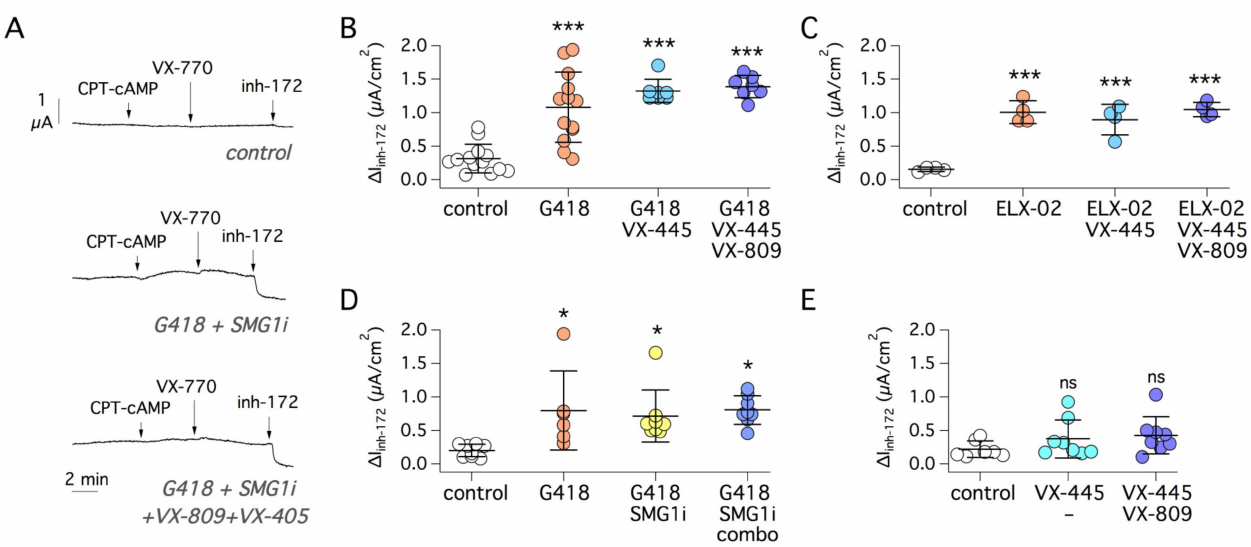
Figure 5. Pharmacological rescue of R1162X-CFTR mutant. ( A ) Representative short-circuit current traces from experiments on 16HBE14o- cells expressing R1162X-CFTR. ( B , C ) Scatter dot plots summarizing the effect of G418 or ELX-02 (both at 0.5 mg/mL) with/without correctors VX-809 (1 µ M) and VX-445 (5 µ M). ***, p < 0.001 vs. control. ( D ) Data obtained with G418, with/without SMG1i (1 µ M), and VX-809/VX-445 (combo). *, p < 0.01 vs. control. ( E ) Data obtained with CFTR correctors, VX-809 (1 µ M) and VX-445 (5 µ M), in the absence of readthrough agents or NMD inhibitor. ns, not